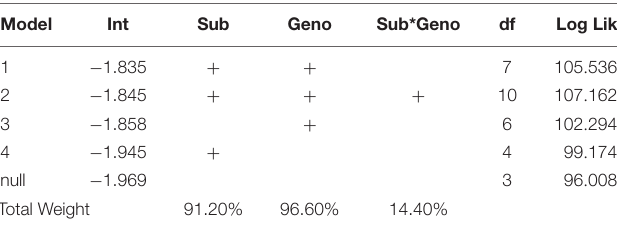
TABLE 2 | Results of multi-model